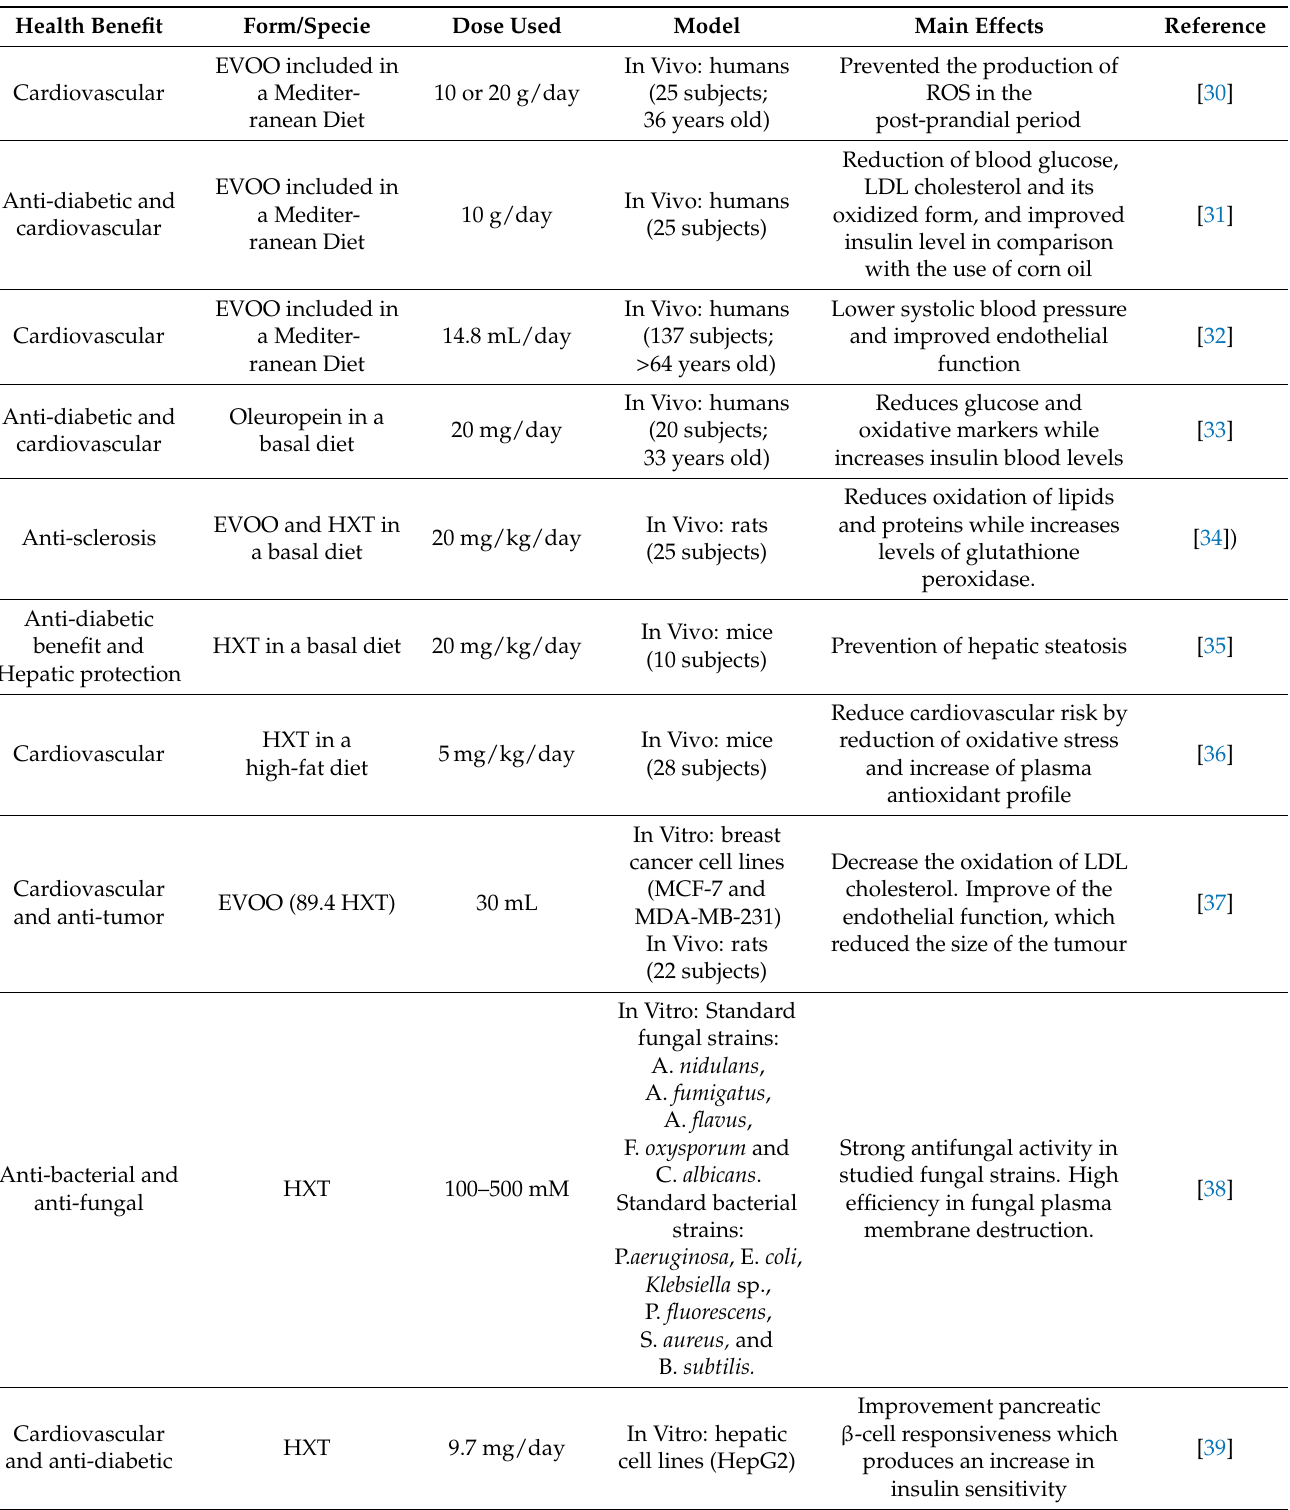
Table 1. Health benefits of olive derivatives consumption as in vitro as in